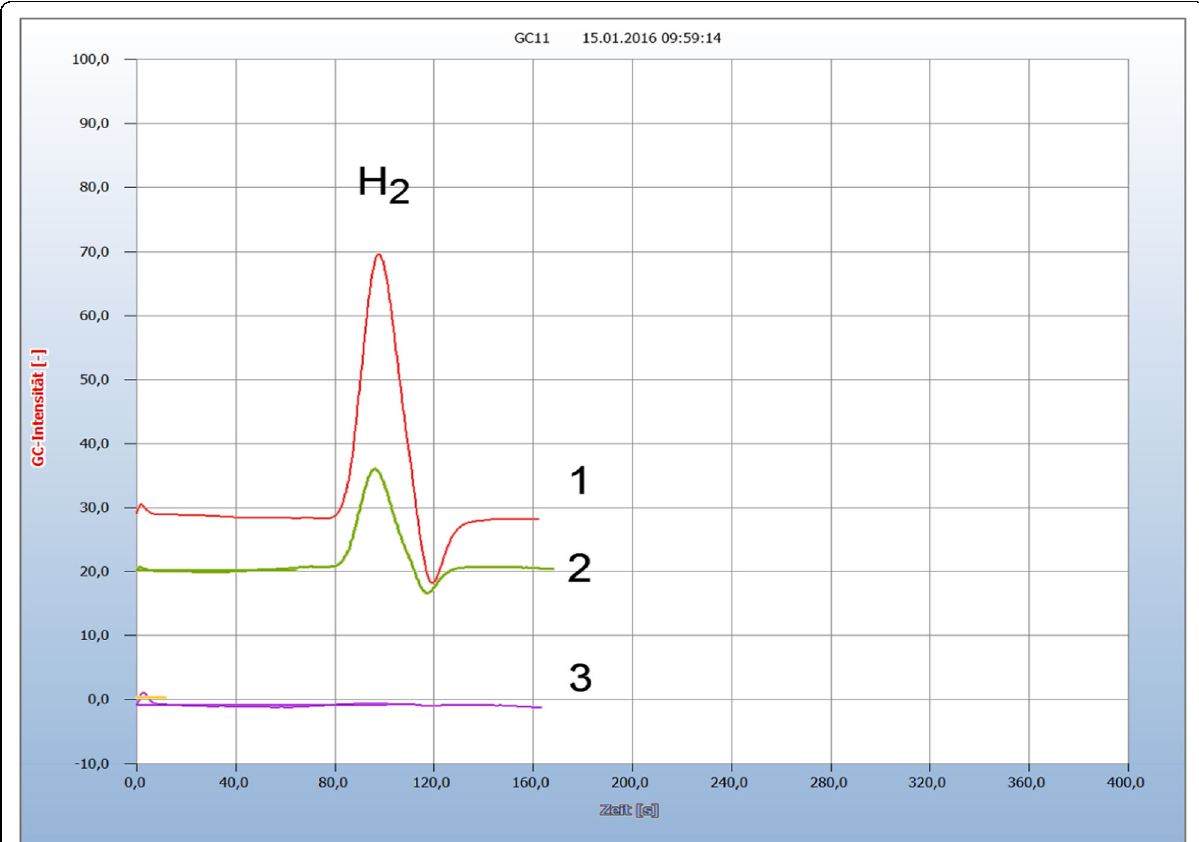
Fig. 6 Antibiotic resistance against amoxycillin. 1, rabbit with inflamed nose and mouth; 2, added amoxycillin; 3, added tetracycline. GC-column: Chromosorb